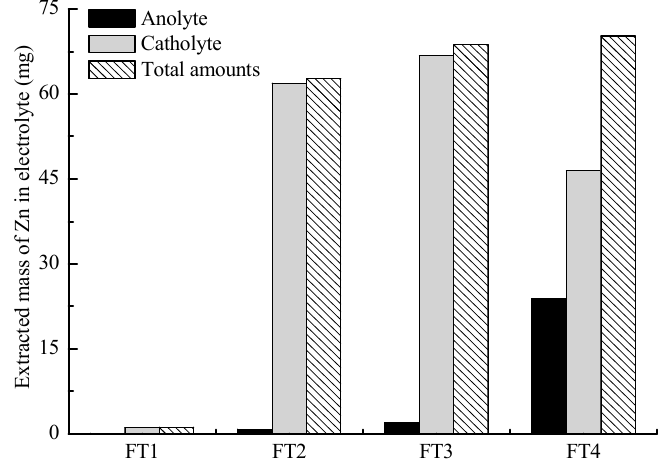
Figure 3. Amounts of Zn extracted in the electrolytes of FT1–FT4 during 9 h electrokinetic treat-